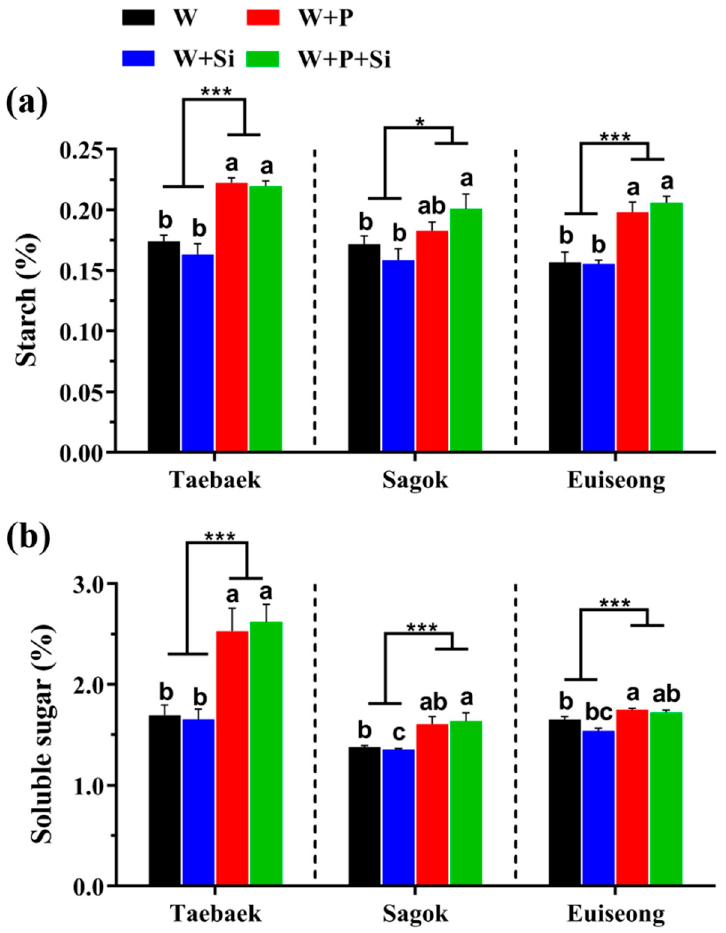
Figure 5. Carbohydrates stock in terms of ( a ) starch (%) and ( b ) soluble sugar (%) contents in the three cultivar petals as affected by the four treatments. n = 4 replicates were averaged and statically analyzed by following Duncan’s multiple comparison range test at p = 0.05 and revealed by different lowercase letters. Statistical differences between P ( − ) and P (+) were determined by an unpaired two-tailed Student’s t test at p < 0.05 (*), and < 0.001 (***), and P ( − ) was considered as the control group. Error bars denote means ± SE.